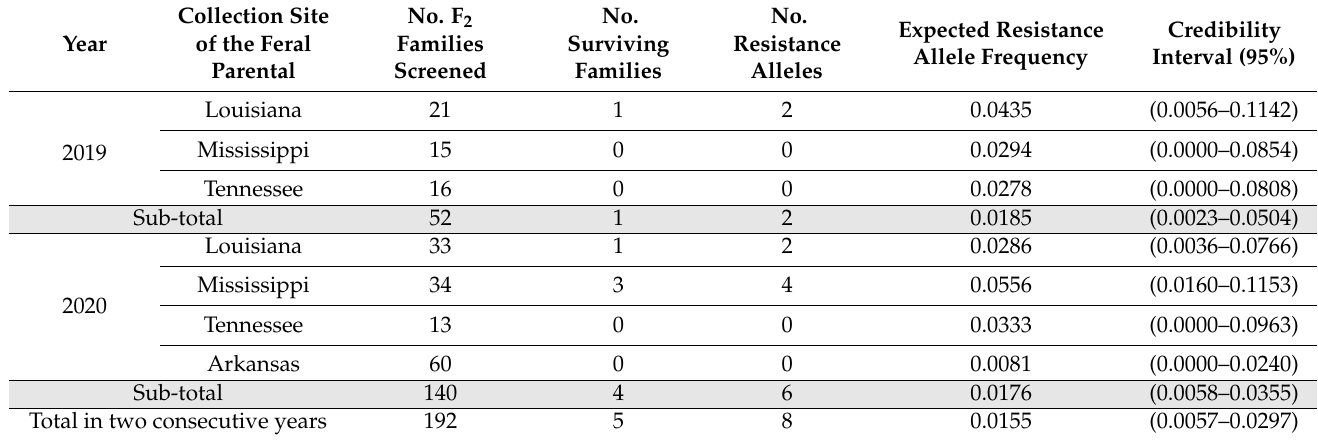
Table 6. Expected resistance allele frequency of Helicoverpa zea to